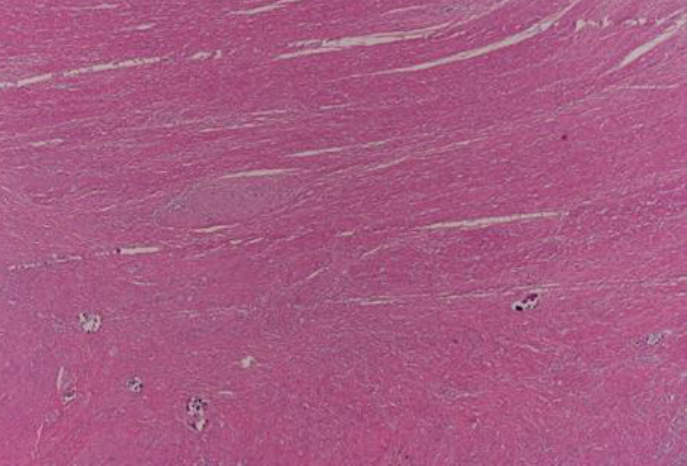
Curr. Oncol. 2023 , 30, FOR PEER REVIEW Figure 3. Moderate pathological response (TRG1); x 40 HE; Calcifications in the muscularis pro- Figure 3. Moderate pathological response (TRG1); x 40 HE; Calcifications in the muscularis pro- Figure 3. Moderate pathological response (TRG1); x 40 HE; Calcifications in the muscularis propria. pria. pria.